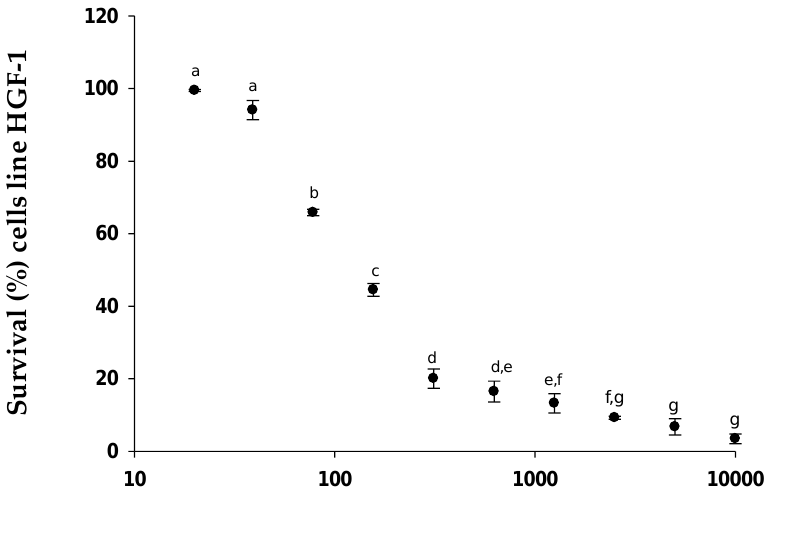
Figure 6. % Survival of cell line HGF-1 (human gingival fibroblasts), very proliferative, exposed to different concentrations of EgPs. Similar letters (a to g) indicate that there were no significant differences (Tukey, p < 0.05) between the different concentrations.